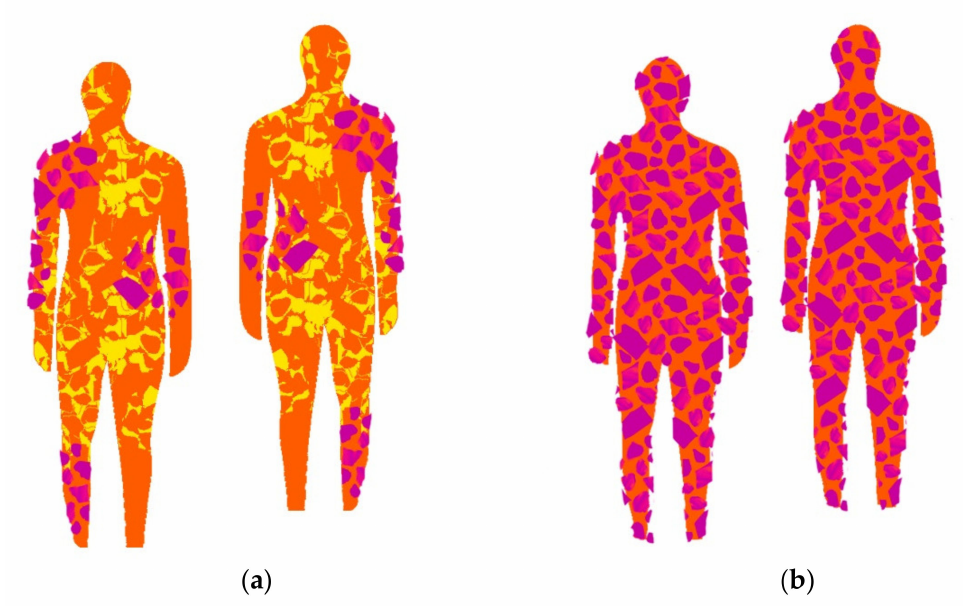
Figure 13. The conceptualized thermal camouflage prototypes: ( a ) Illustration of the front and back of the diurnal thermal camouflage prototype; ( b ) Illustration of the front and back of the nocturnal thermal camouflage prototype.